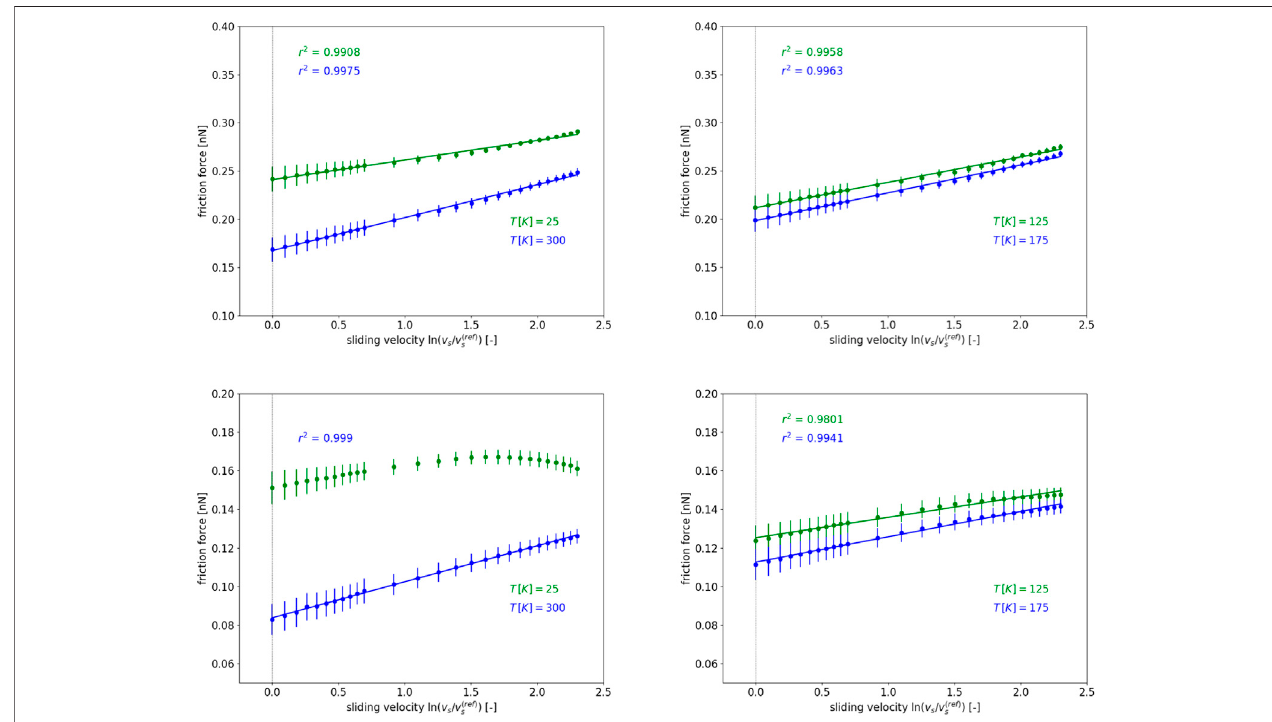
FIGURE 9 | Temperature and sliding velocity dependence of the friction force as predicted by the 2D PT-model within the stick-slip regime along the incommensurate path for Φ (cid:2) 15 deg, when either U 0 (top row) or k c (bottom row) is kept constant in Eq. 14 .